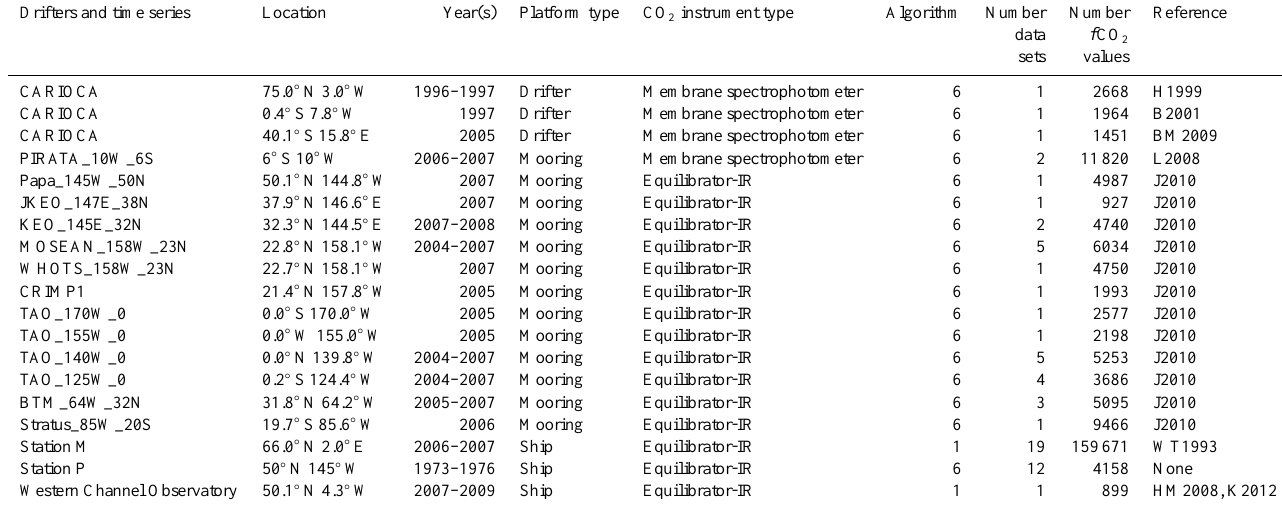
Table 7. Drifters and time series in SOCAT version 2 with the location, year(s) of operation, platform type, CO 2 instrument type, algorithm used for (re-)calculation of f CO 2 (Table 8), number of data sets, number of f CO 2 values with a WOCE flag of 2, and reference.